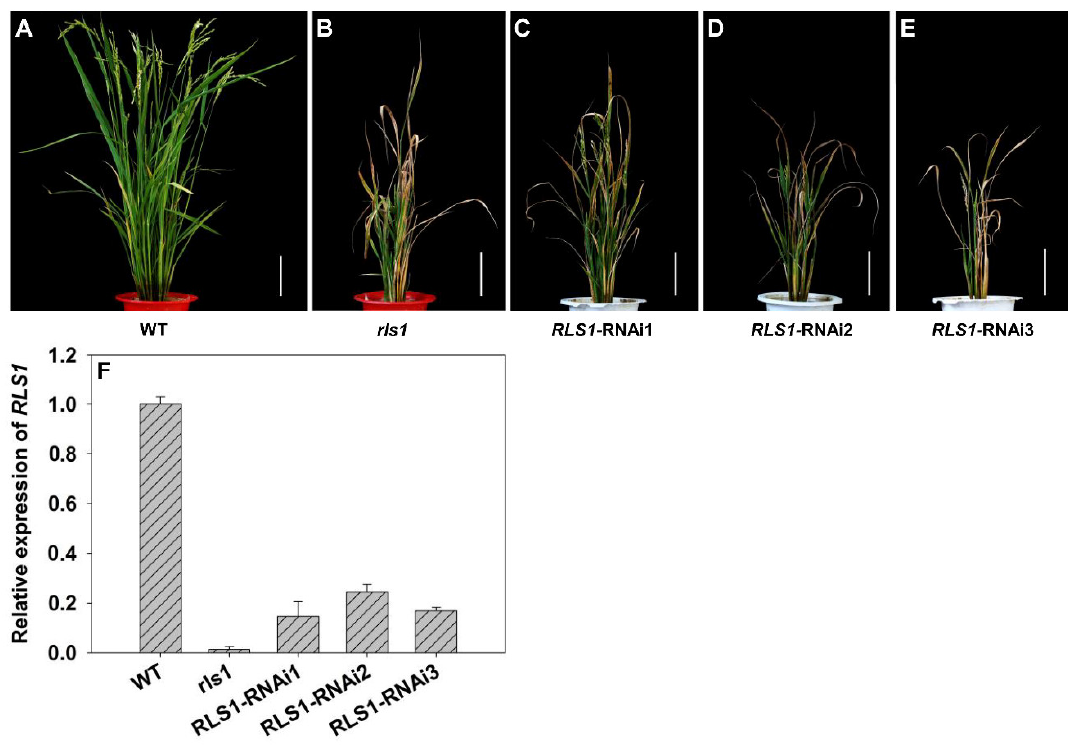
Figure 3. Comparison of WT, rls1 and RLS1 -RNAi plants at the reproductive stage. ( A , B ) The performance of ( A ) WT, ( B ) rls1 plants grown in paddy soil to the heading stage (bars: 15 cm); ( C – E ) the phenotype of an RLS1 -RNAi transgenic plant at the heading stage (bars: 15 cm); ( F ) the abundance of RLS1 transcript in the fully expanded leaf of WT, rls1 and RLS1 -RNAi. For normalization purposes, the transcript abundance of RLS1 in WT was set to 1. Values are expressed in the form mean ± SE ( n = 3).